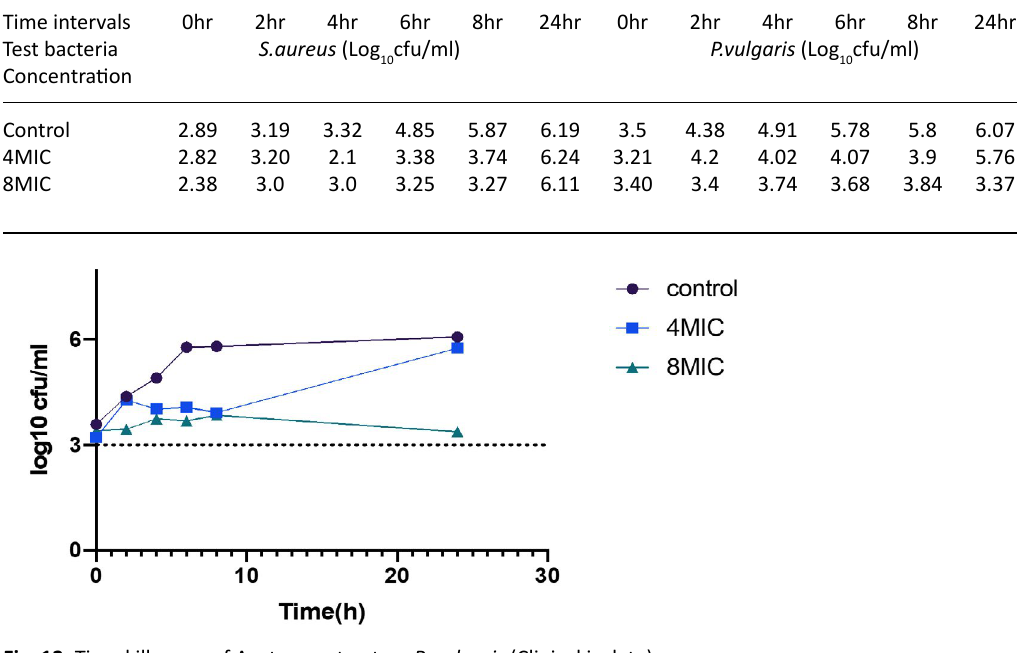
Fig. 12. Time kill curve of Acetone extract on P. vulgaris (Clinical isolate).